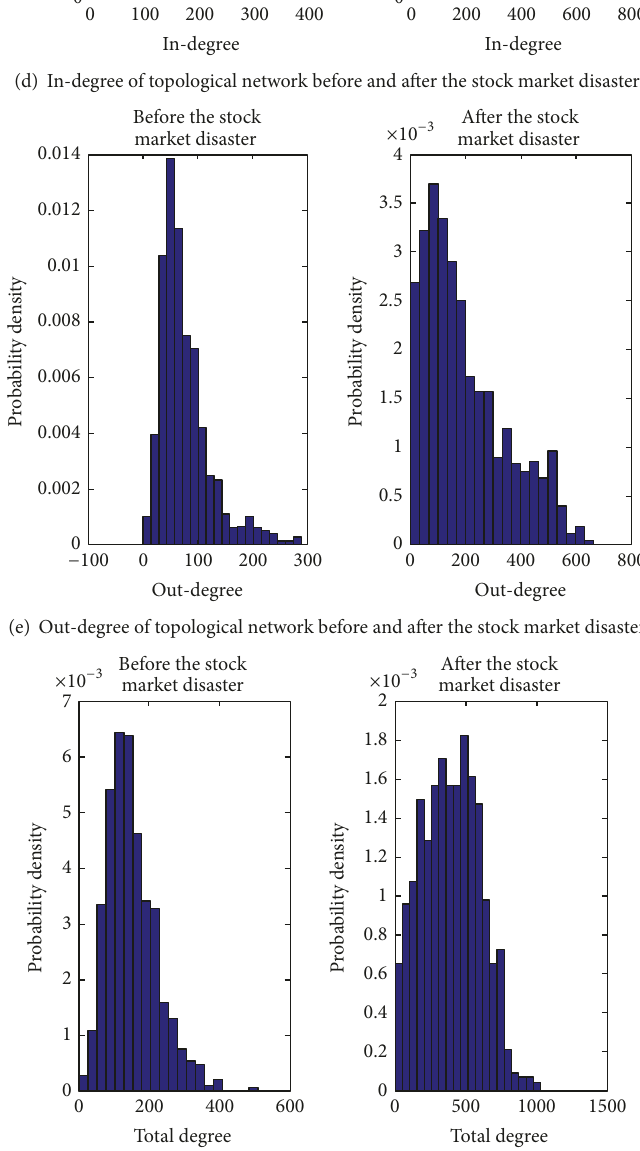
(f) Total degree of topological network structure before and after the stock market disaster Figure 2: Strength distribution and degree distribution before and after the stock market